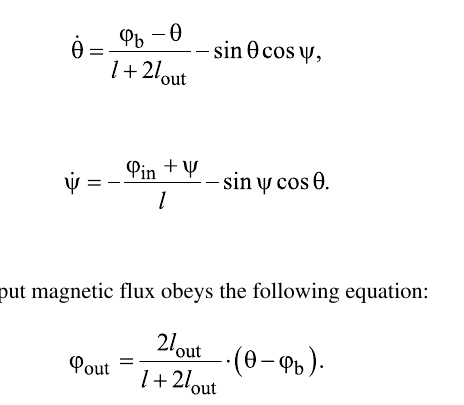
Equations of motion were obtained in terms of half-sum and half-difference of Josephson phases φ 1 , φ 2 ( θ = ( φ 1 + φ 2 )/2